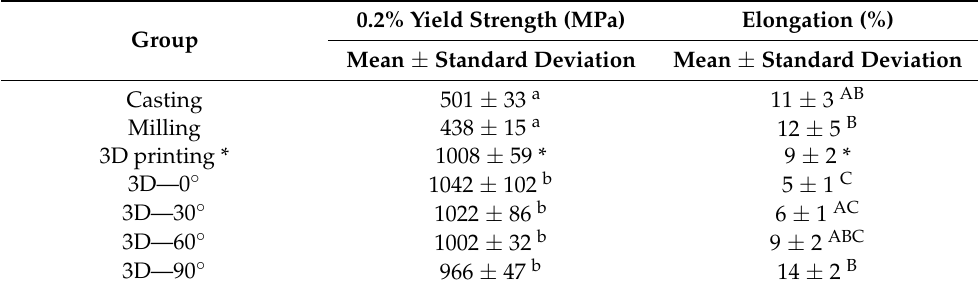
* 3D printing result means the average value. ab Different letters correspond to statistical differences for group ( p < 0.05). ABC Different letters correspond to statistical differences for group ( p < 0.05). Values a,b,c are subsets of